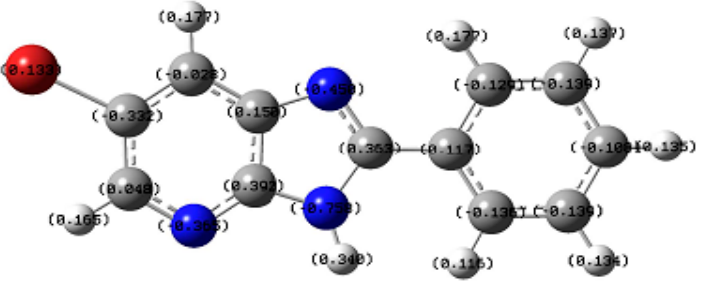
Figure 7. Optimized structure of compound ( 1 ).